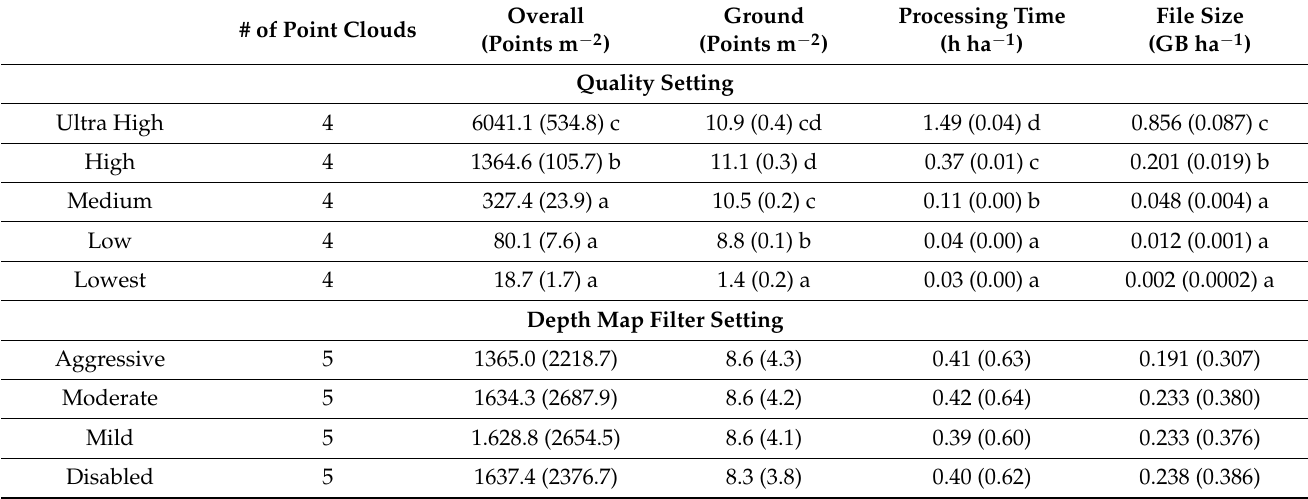
Table 2. Influence of Metashape build dense cloud Quality and depth map filter settings on the mean (standard deviation) of overall and ground point return density, along with total processing time and point cloud file size. Letters represent significant differences ( α = 0.05) determined by two-way ANOVA with Tukey’s honestly significant difference (HSD)